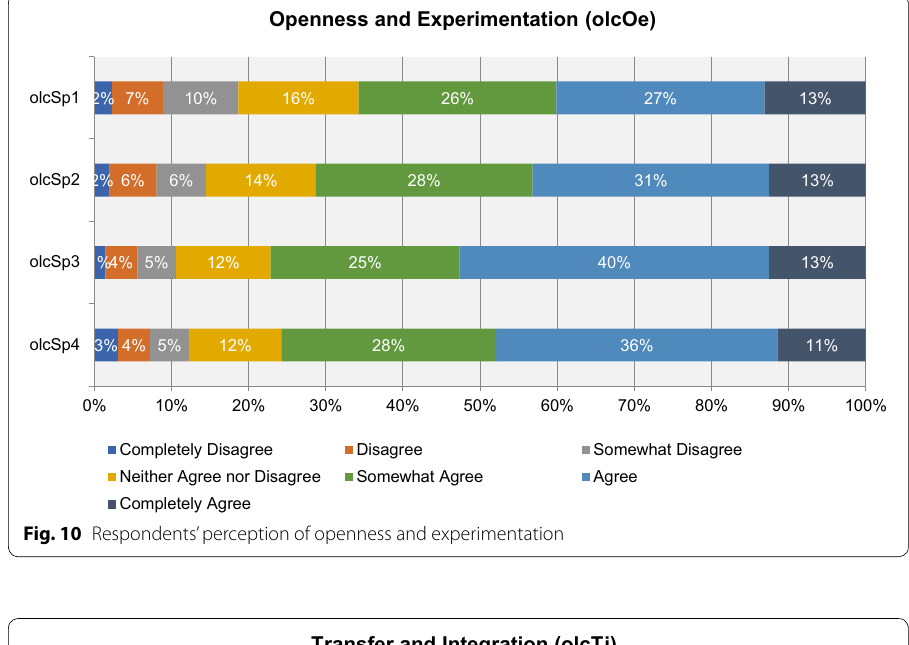
Fig. 10 Respondents’ perception of openness and experimentation